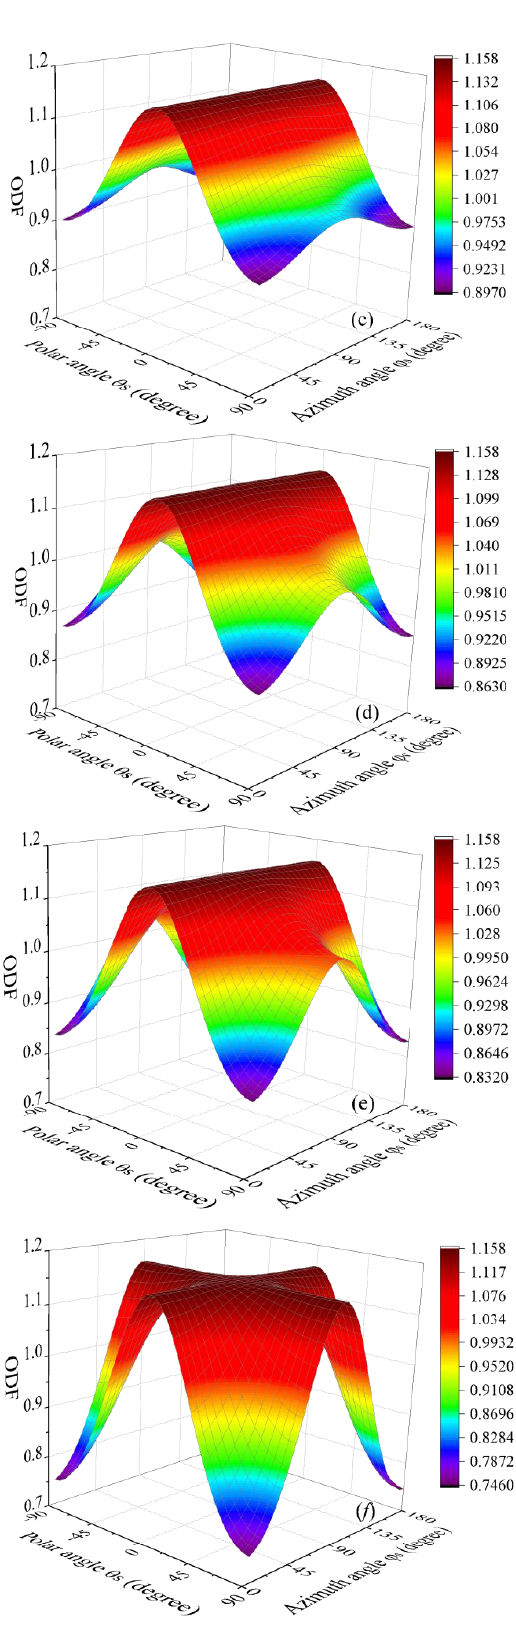
Figure 3. Orientation distribution function ( a ) ε 2 = –ε 3 ; ( b ) uni-axial stretching, ε 2 = −0.48ε 3 ; ( c ) ε 2 = −0.25ε 3 ; ( d ) ε 2 = 0; ( e ) ε 2 = 0.25ε 3 ; ( f ) ε 2 = ε 3 . The comparison in Figure 3 indicates that compared to uni-axial stretching, there exists critical Euler angles, for which the stretching in X 2 direction does not change the ODF. For example, the contour graph in Figure 4 shows the difference between the two ODFs, i.e., ρ bi-axial –ρ uni-axial , where ρ uni-axial and ρ bi-axial denote the ODFs under uni-axial stretching (ε 3 = 5%) and equal bi-axial stretching (ε 3 = ε 2 = 5%), respectively. The flat plane represents the limiting case when ρ bi-axial – ρ uni-axial = 0. The two curves intersected by the contour and the plane result in the critical Euler angles. Obviously, bi-axial stretching increases the ODF above the flat plane while it decreases the ODF under the plane. Figure 4. Difference between two ODFs. Figure 5 plots the shape of the critical Euler angles with considering the effects of Poisson’s ratio, strain ratio and stretching strain in X 3 direction. The significant variations in the shape and area of region Ι in Figure 5a indicate that Poisson’s ratio has considerable effects on the critical Euler angles and Young’s modulus of the composites. With fixed Poisson’s ratio, Figure 5a,b suggests that the stretching strain ratio and the stretching strain in X 3 direction have limited effects on the critical Euler angles.